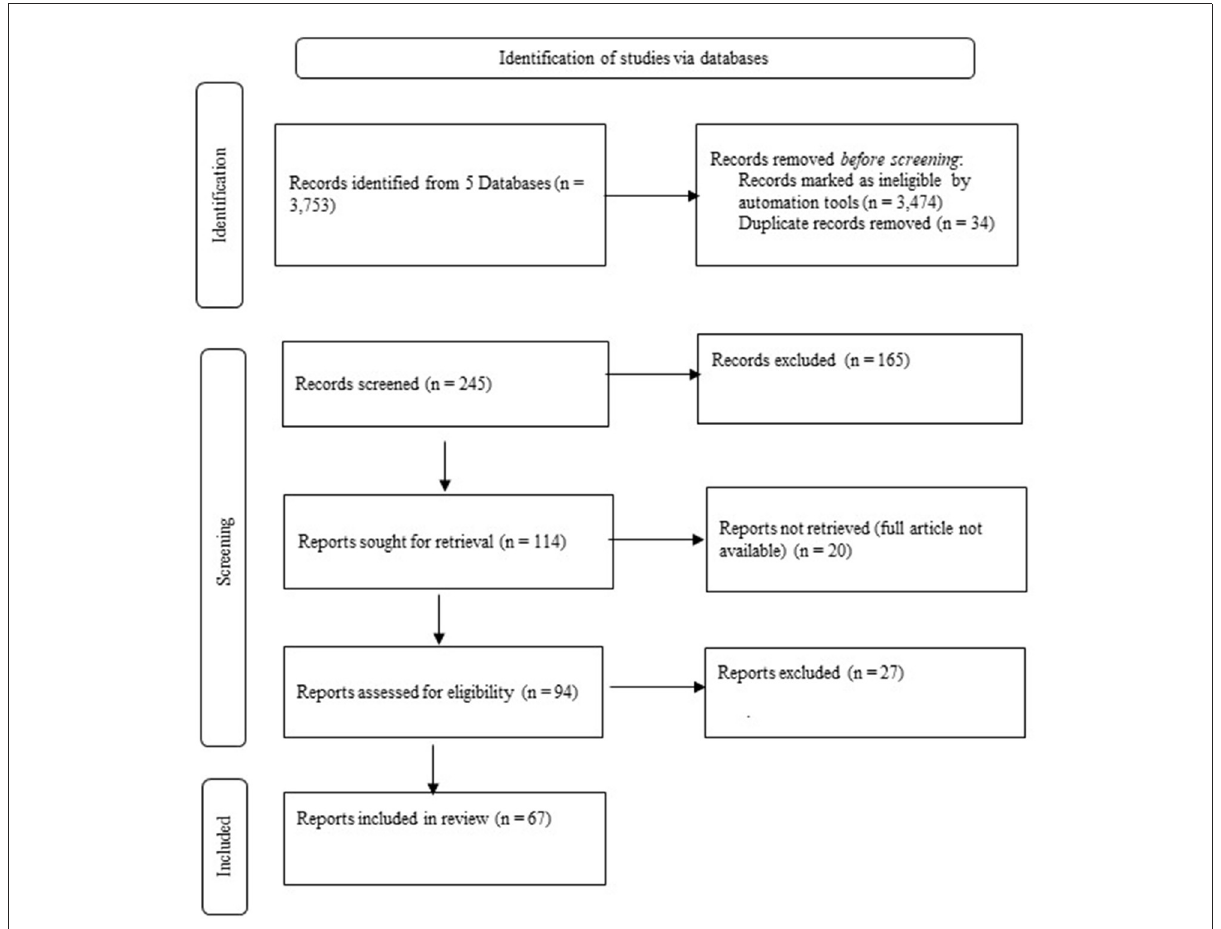
FIGURE2 PRISMA diagram for the search protocol and the inclusion and exclusion of reviewed articles.